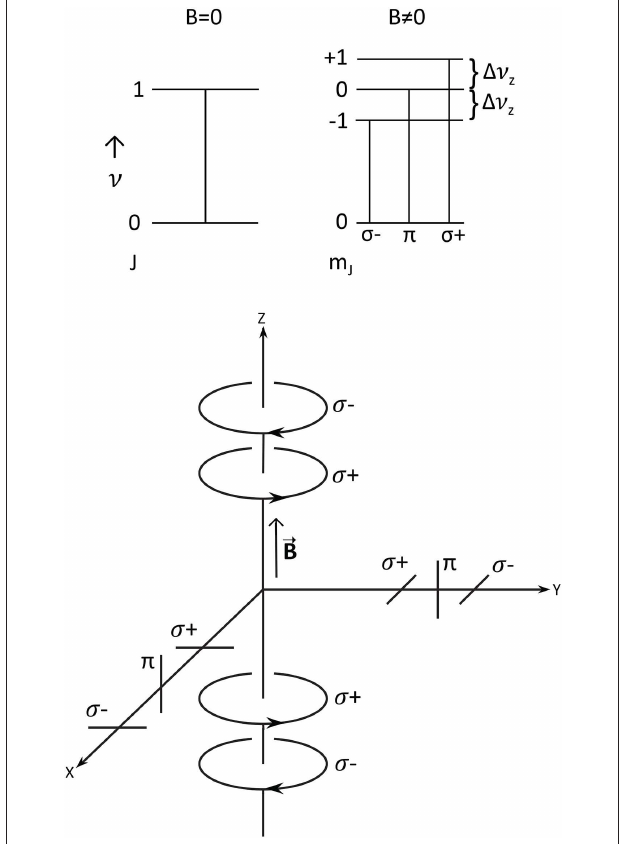
FIGURE 1 | Top : Energy level diagram showing Zeeman splitting. Bottom : Polarizations that would be observed from different angles with respect to the magnetic